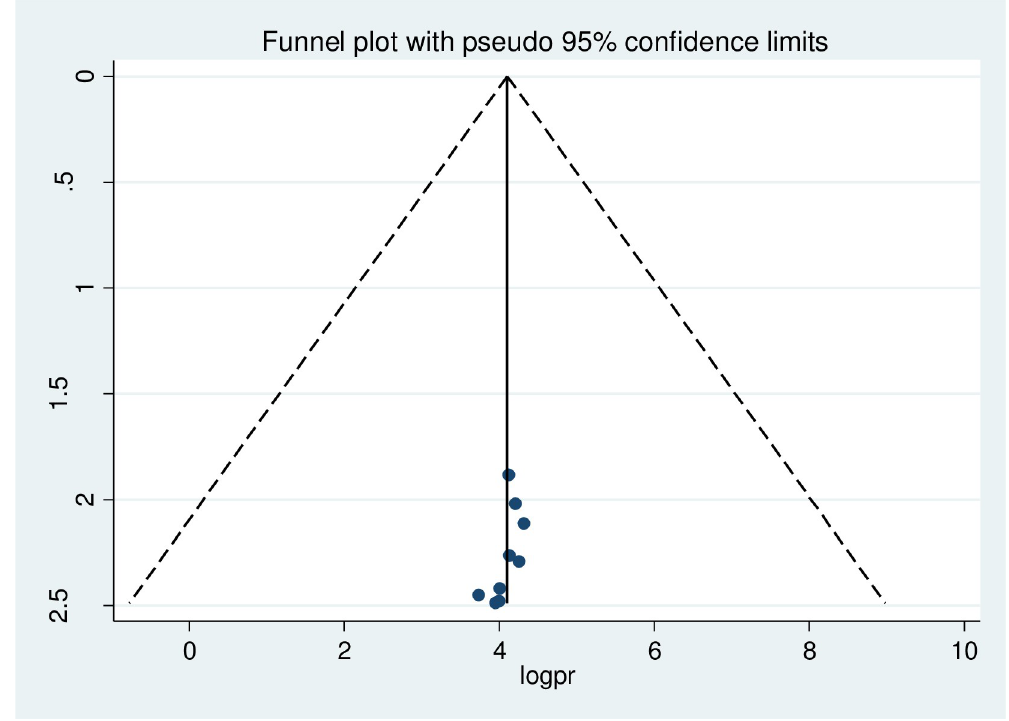
Fig 6. Assessment of publication bias for attitude of pregnant women’s towards COVID-19 infection